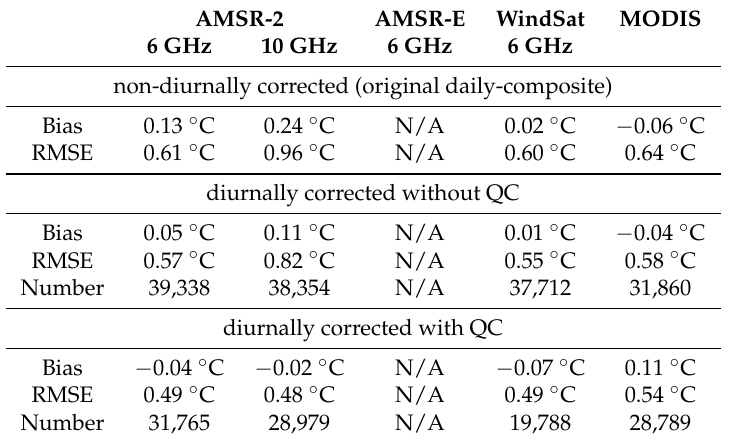
Table 4. Same as Table 3, but against in situ foundation SST measurements by Argo